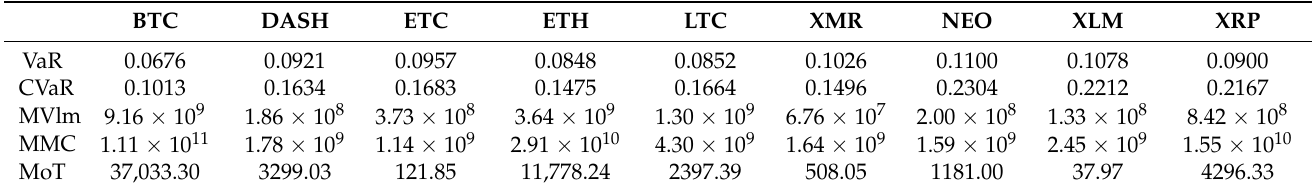
Table 2. Values of other criteria for the whole